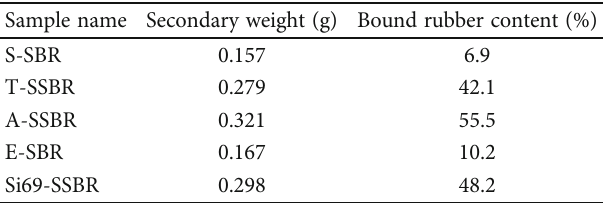
Table 5: The calculated bound rubber contents of the samples.